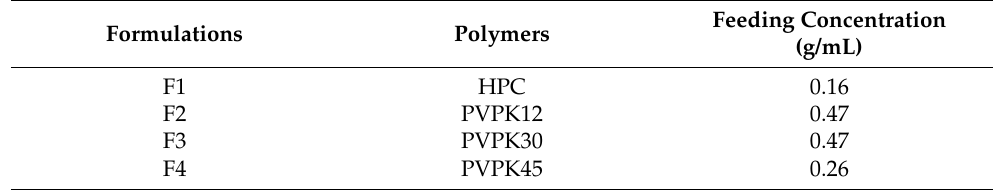
Feeding Concentration (g/mL)